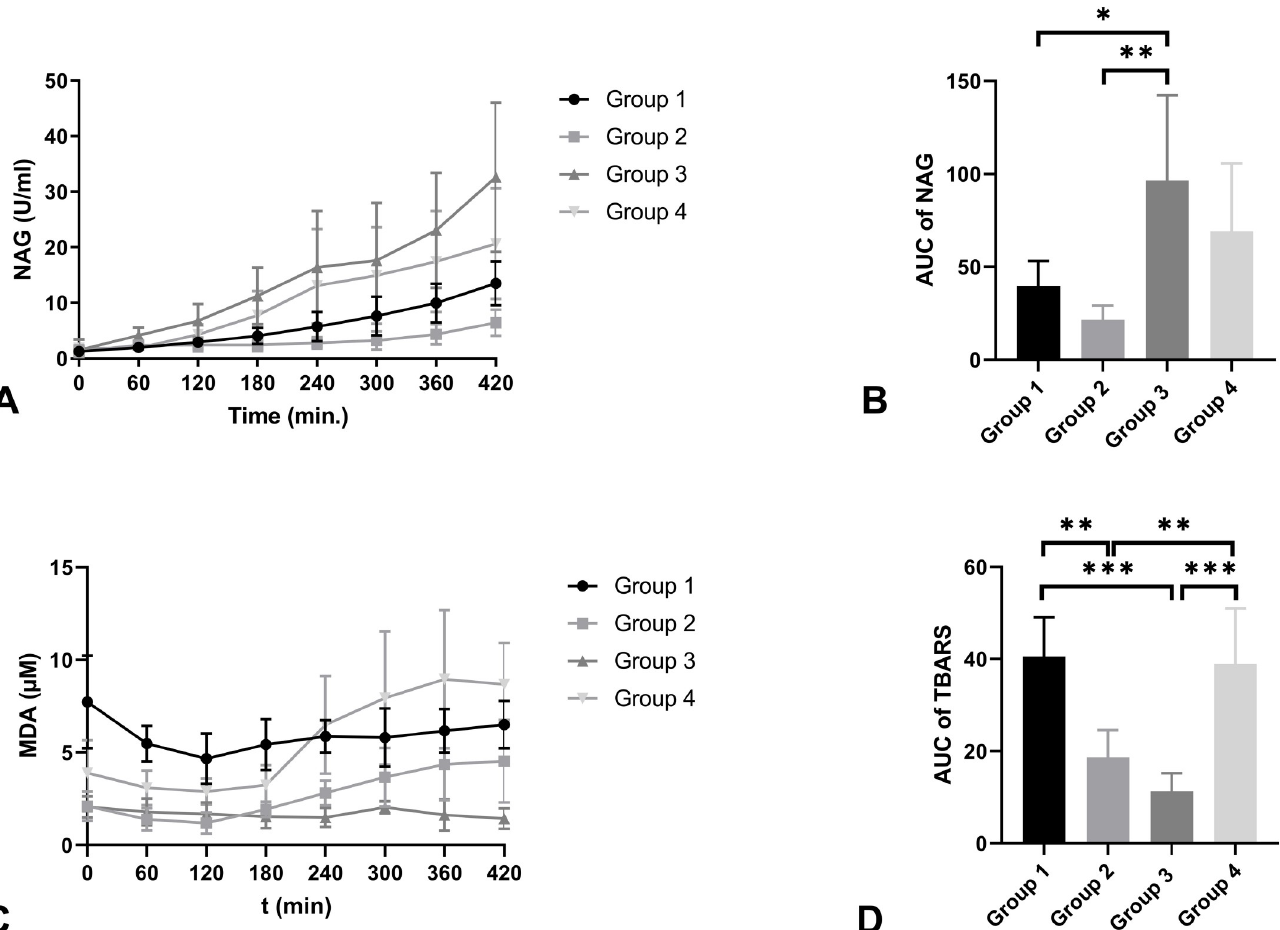
Fig 8. Mean NAG levels (U/L) (A) and AUC of NAG (B), mean MDA levels (uM) (C), and AUC of MDA (D) of the four experimental groups during NMP (+ SD). � indicates a level of significance of p � 0.05. �� indicates a p-value of � 0.01. ��� indicates a p-value of p � 0.001.